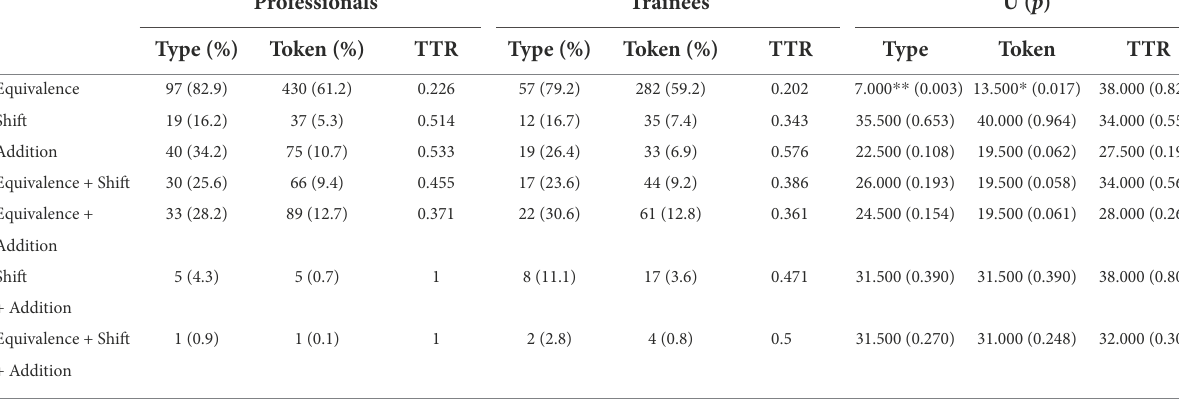
TABLE 3 Strategical distributions of four-word lexical bundles from the two